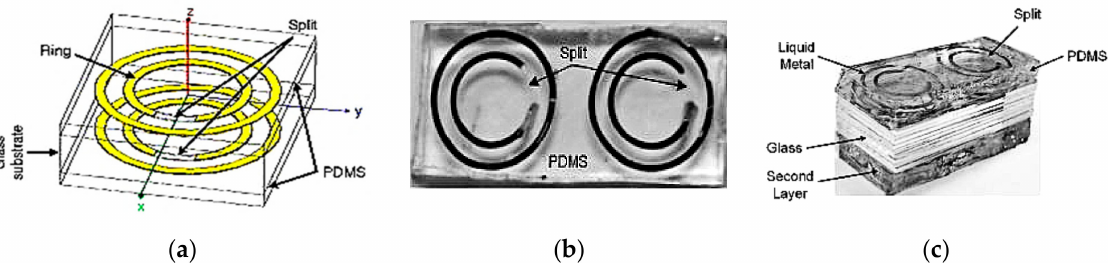
Figure 26. Unit cell of the nested ring-split ring transmitarray. ( a ) Double layered. ( b ) One layer for the rotation angle of 20 ◦ . ( c ) Fabricated double layered antenna